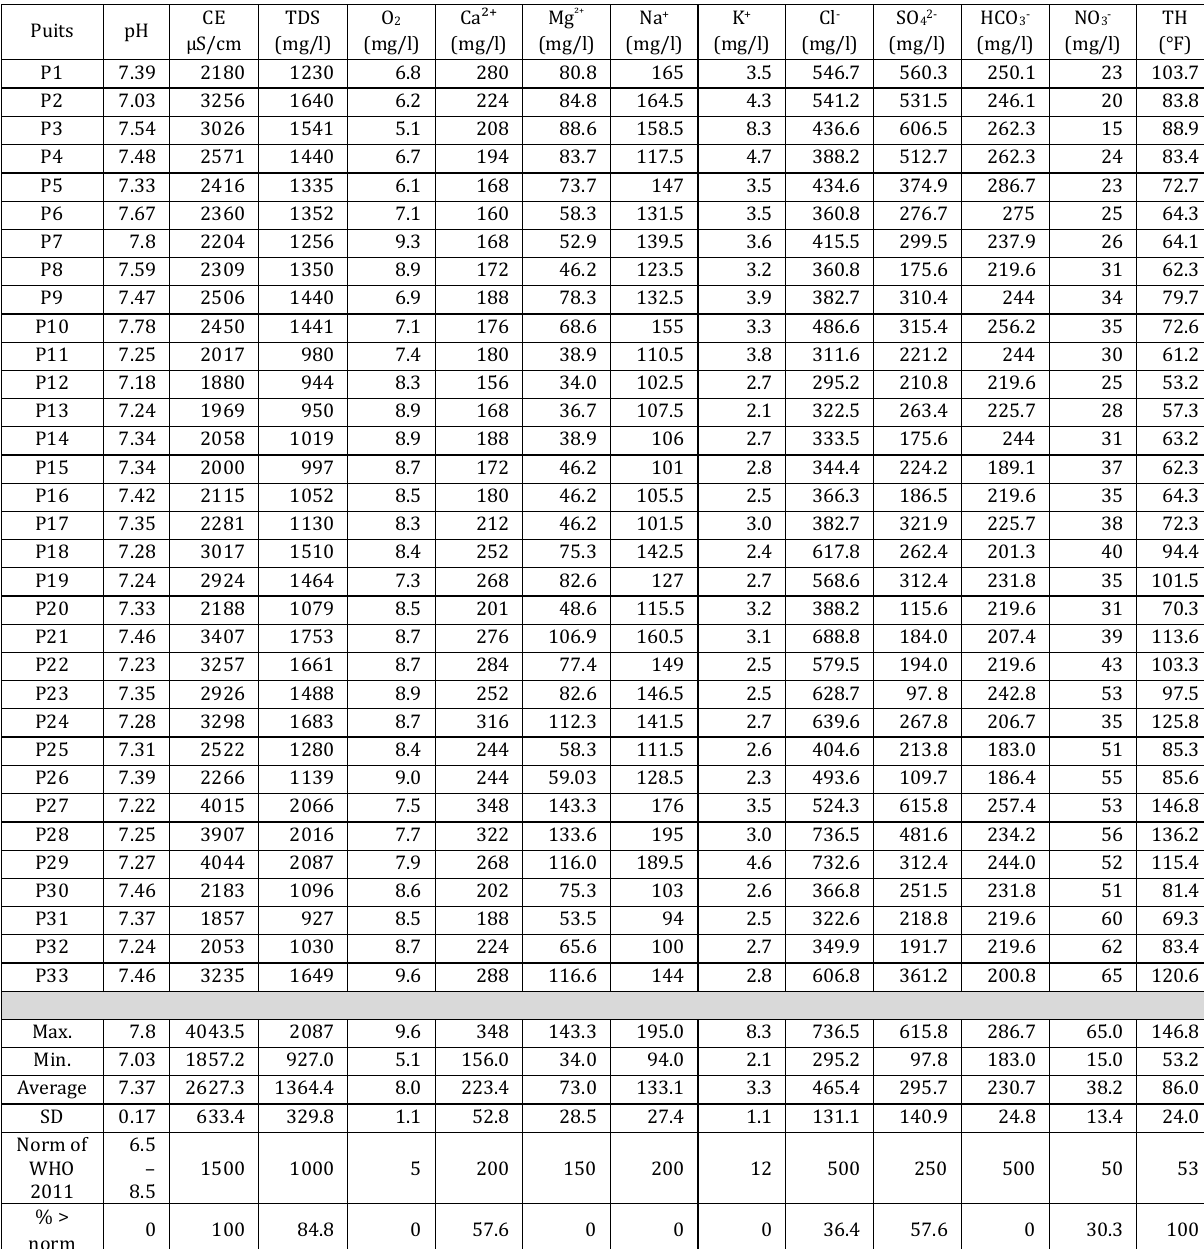
Table 1 . Results of physico-chemical analyzes (October